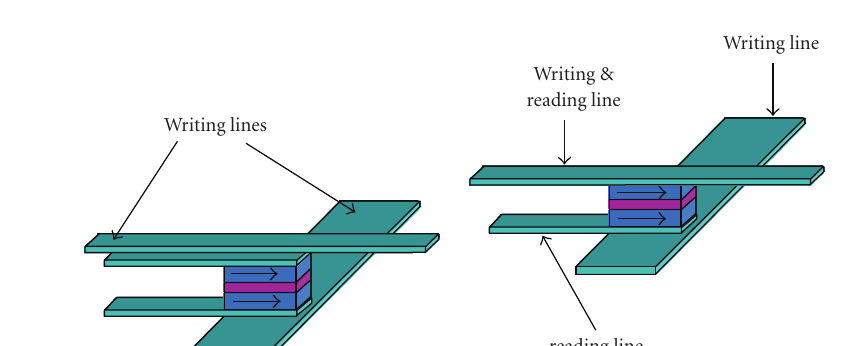
Figure 2: Write mechanism in the FIMS-MTJ.